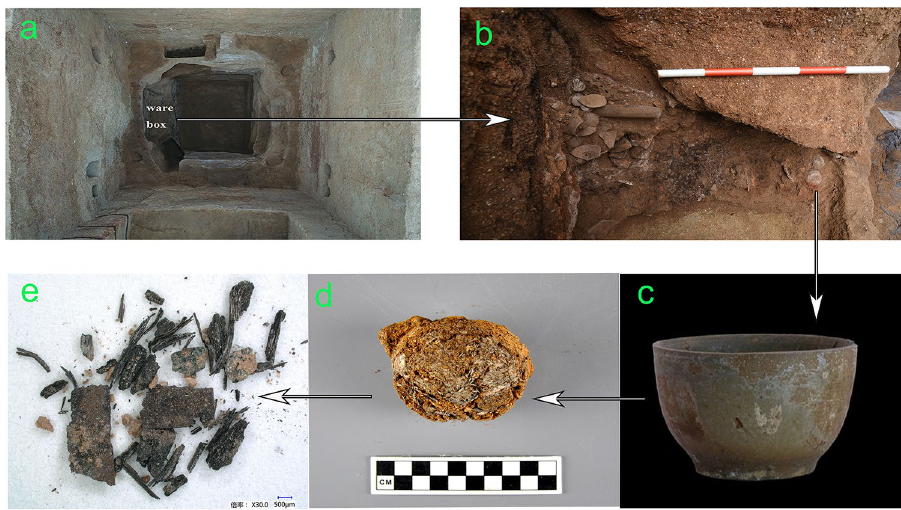
Figure 2. The map shows ( a ) Tomb No. 1 at Xigang; ( b ) Burial objects in the ware box; ( c ) The unearthed bowl; ( d ) The residues which poured out from the bowl; ( e ) The sample CST take from the